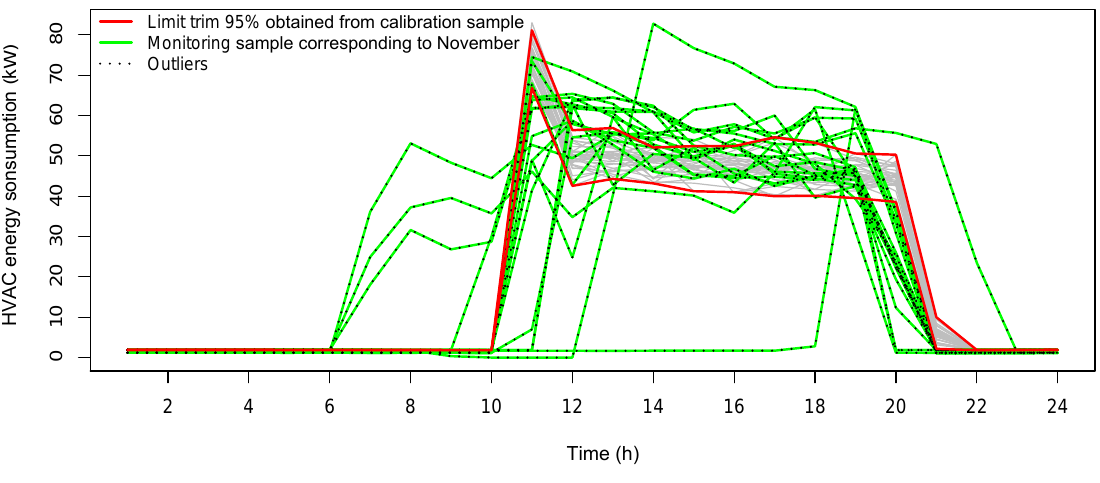
Figure 7. Reference (August and September) and monitoring samples corresponding to